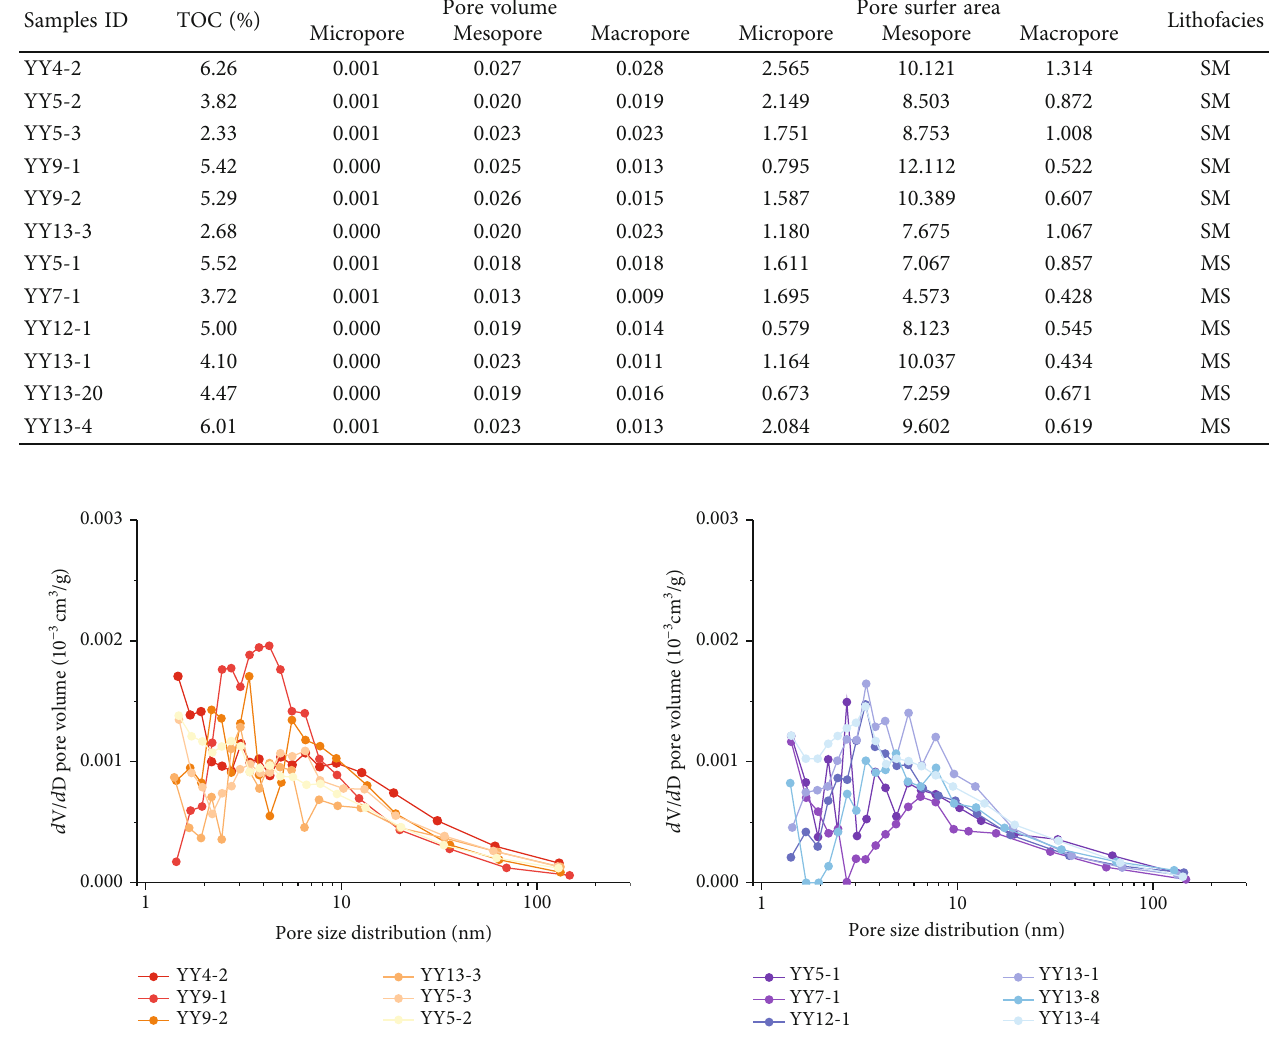
adsorption data. 2